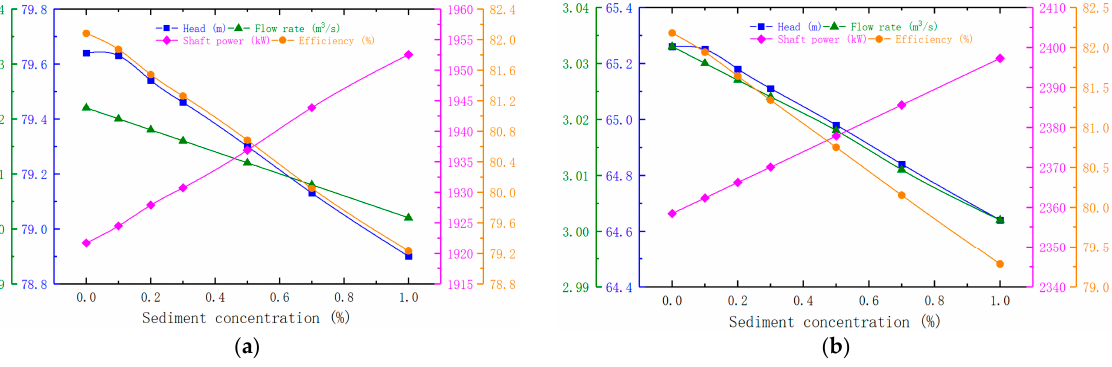
Figure 10. Variation trend diagram of performance parameters of centrifugal pump with different sediment concentrations at 0.8 Q and 1.2 Q conditions: ( a ) 0.8 Q working condition; ( b ) 1.2 Q working condition. Table 4. The errors between the numerical simulation results at the condition of clean water and the performance parameters of centrifugal pump at different flows.